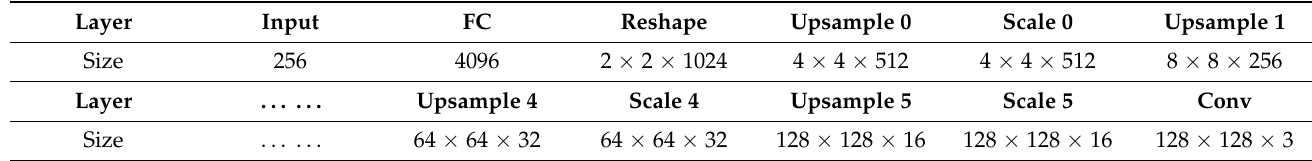
Figure 5. Generator network. Table 2. Output size of the layer in the generator network. Table 2. Output size of the layer in the generator network.